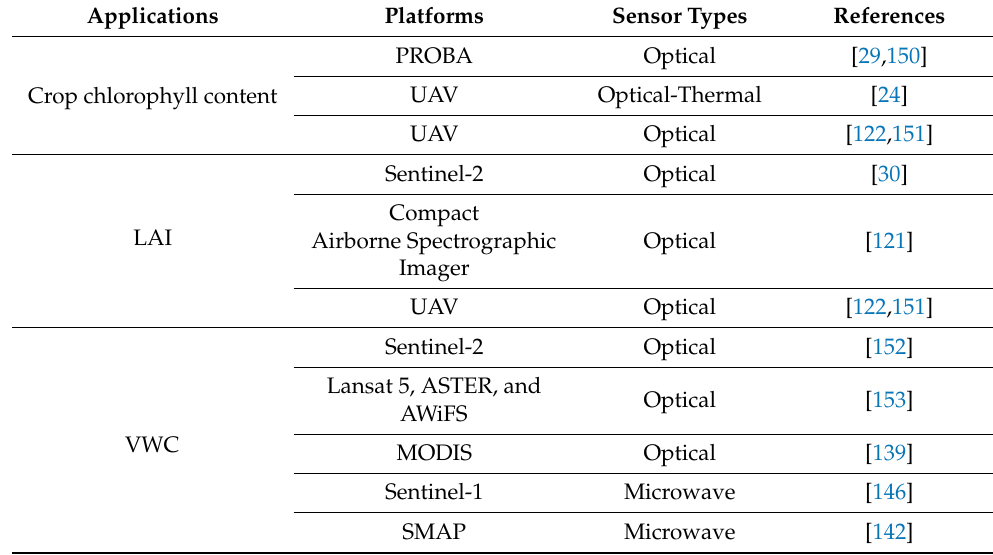
Table 3. A number of remote sensing platforms and sensor types in crop development monitoring.